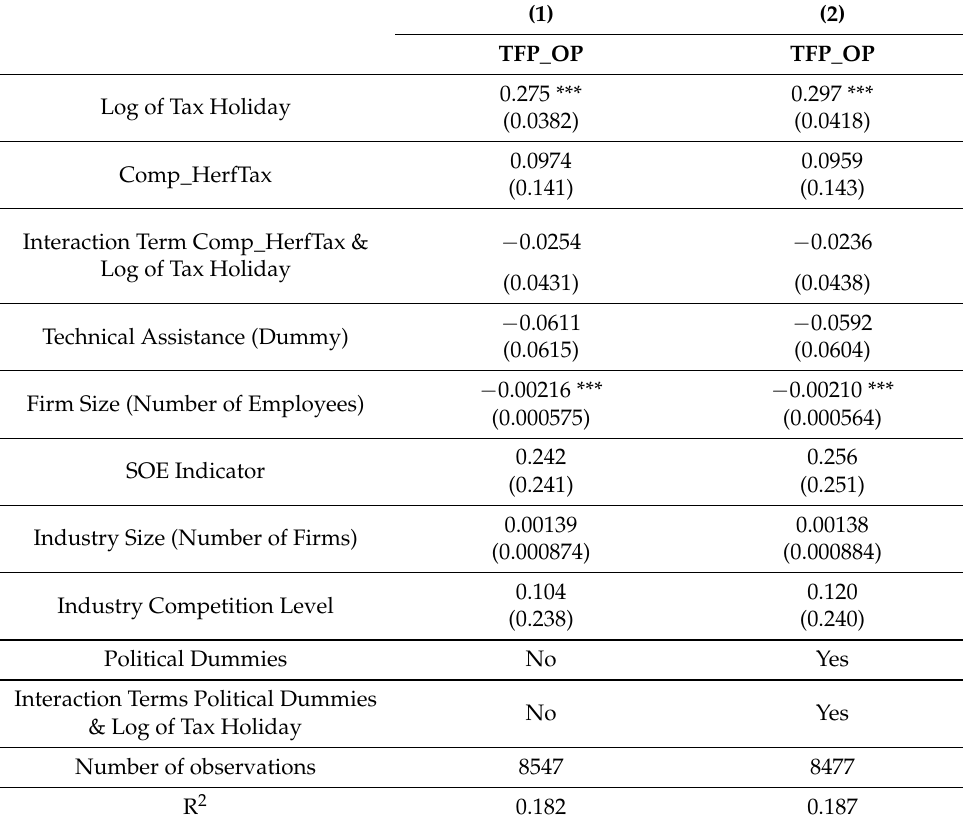
Table A5. Robustness Checks with Targeting Mechanism Focusing on